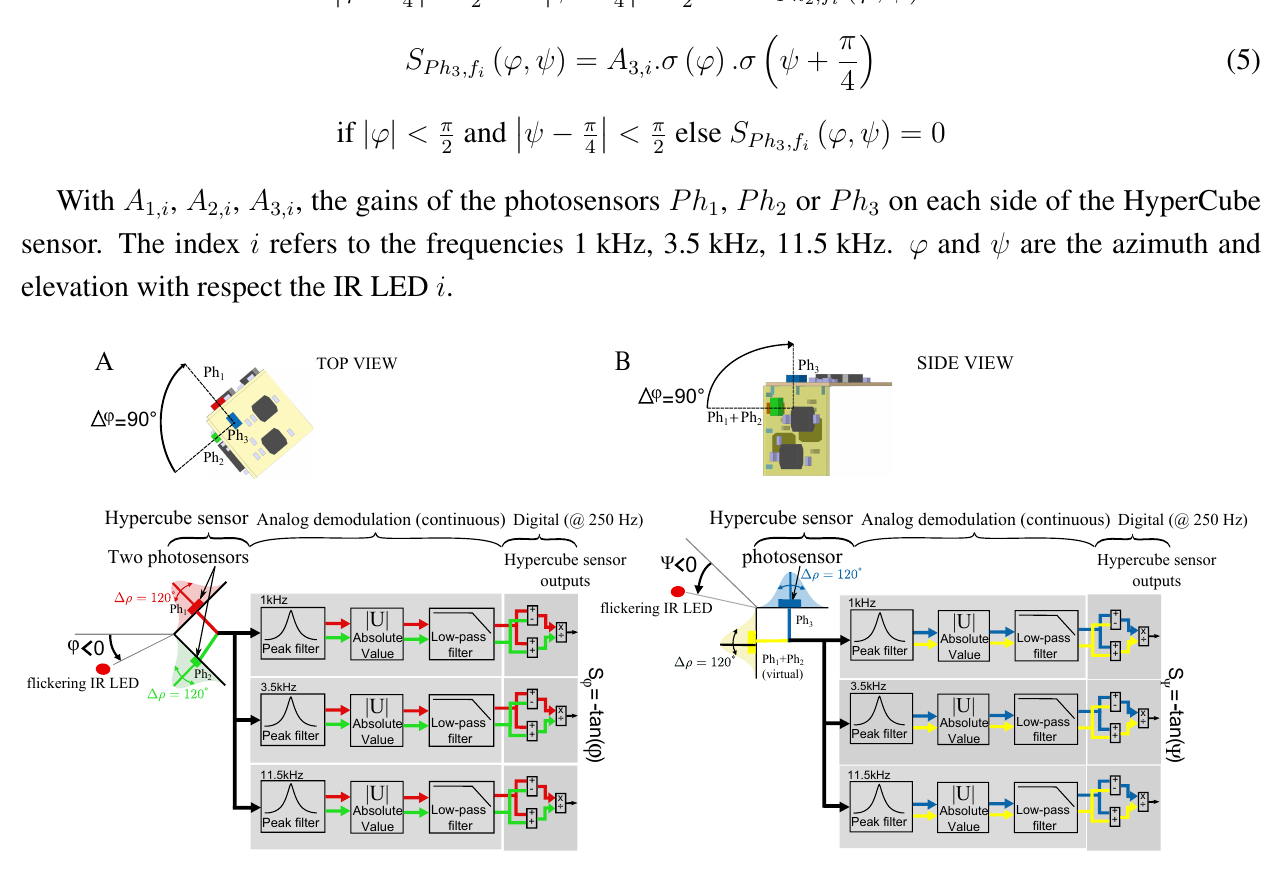
Figure 9. Sketch diagram of the HyperCube signal processing algorithm. ( A ) Top view: the sensor measures the azimuth ϕ